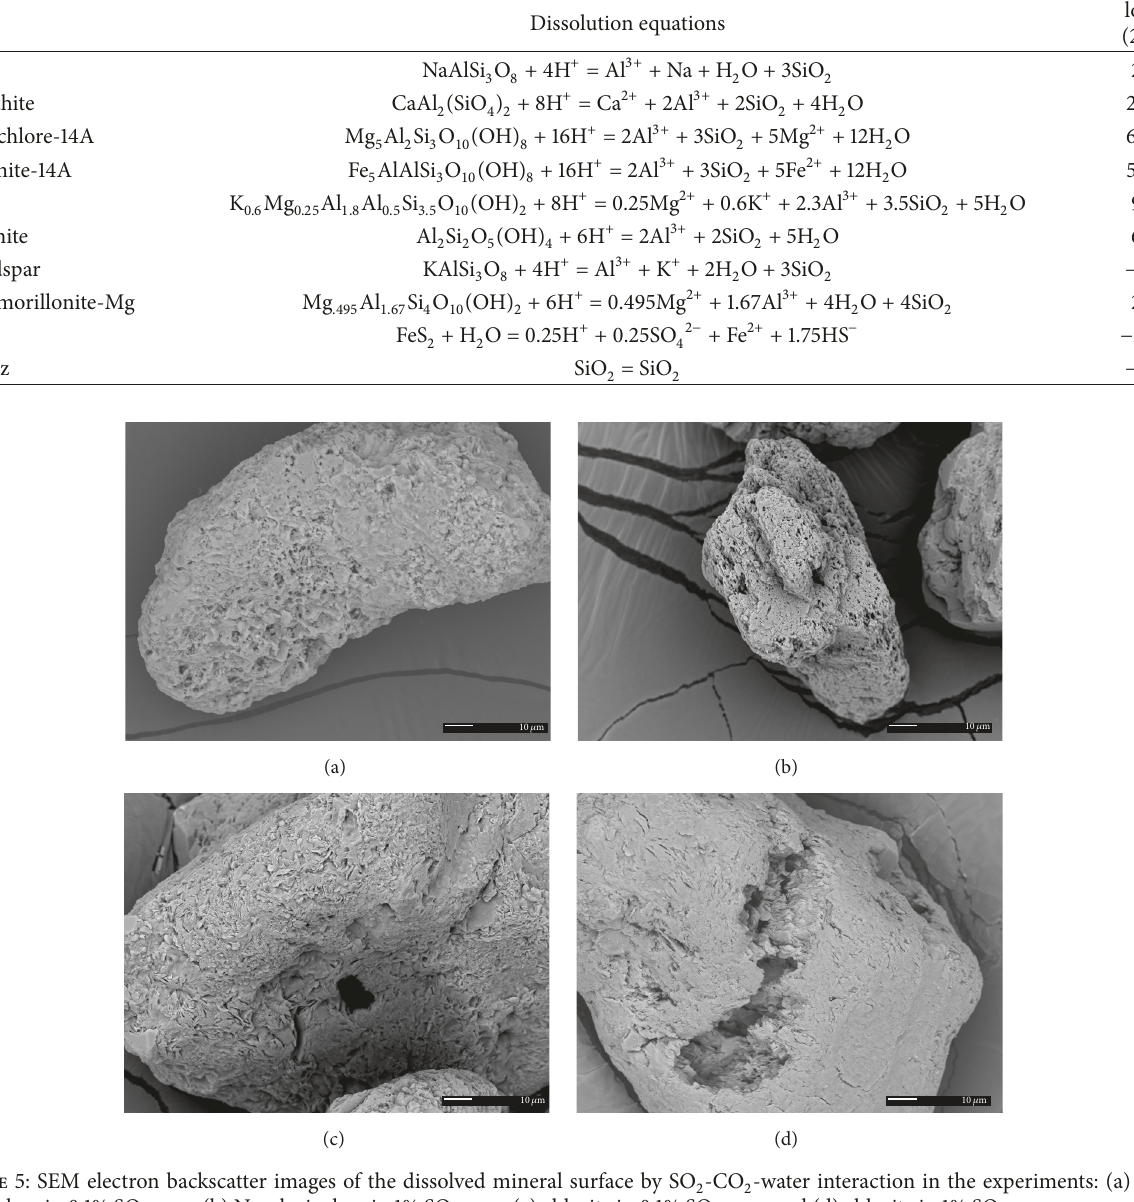
Table 3: Dissolution equations of minerals used in this study.